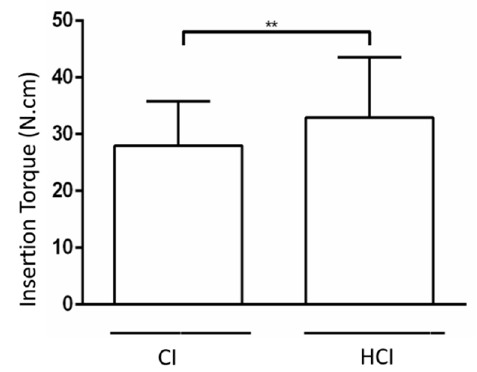
Figure 3. Mean and standard deviation of implant insertion torque with different macrostructures . ** p < 0.01—Di ff erences between groups of implants with di ff erent macrostructures—Paired t-test.